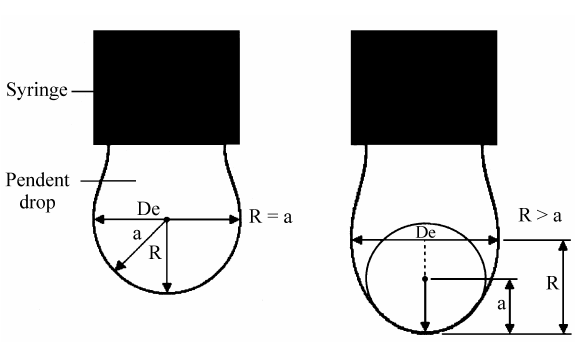
Figure 3. Evaluation of the radius of curvature at the apex of a pendant